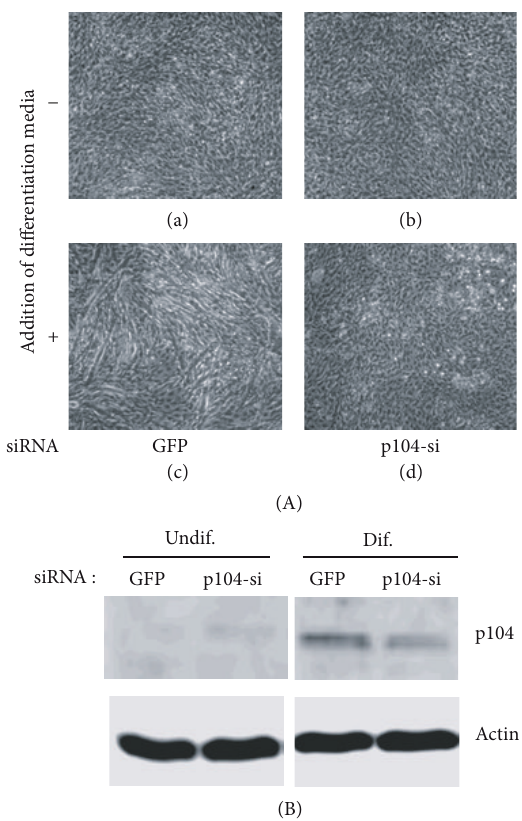
Figure 6: The effect of p104 siRNAs transfection in the myotube differentiation. (A) The C2C12 cells were transfected with p104 siRNA ((b), (d)) and grown in the presence ((c), (d)) or absence ((a), (b)) of differentiation media. The photos were taken 4 days after siRNAs transfection. (B) The decrease of p104 protein in the differentiation condition was shown by Western blot